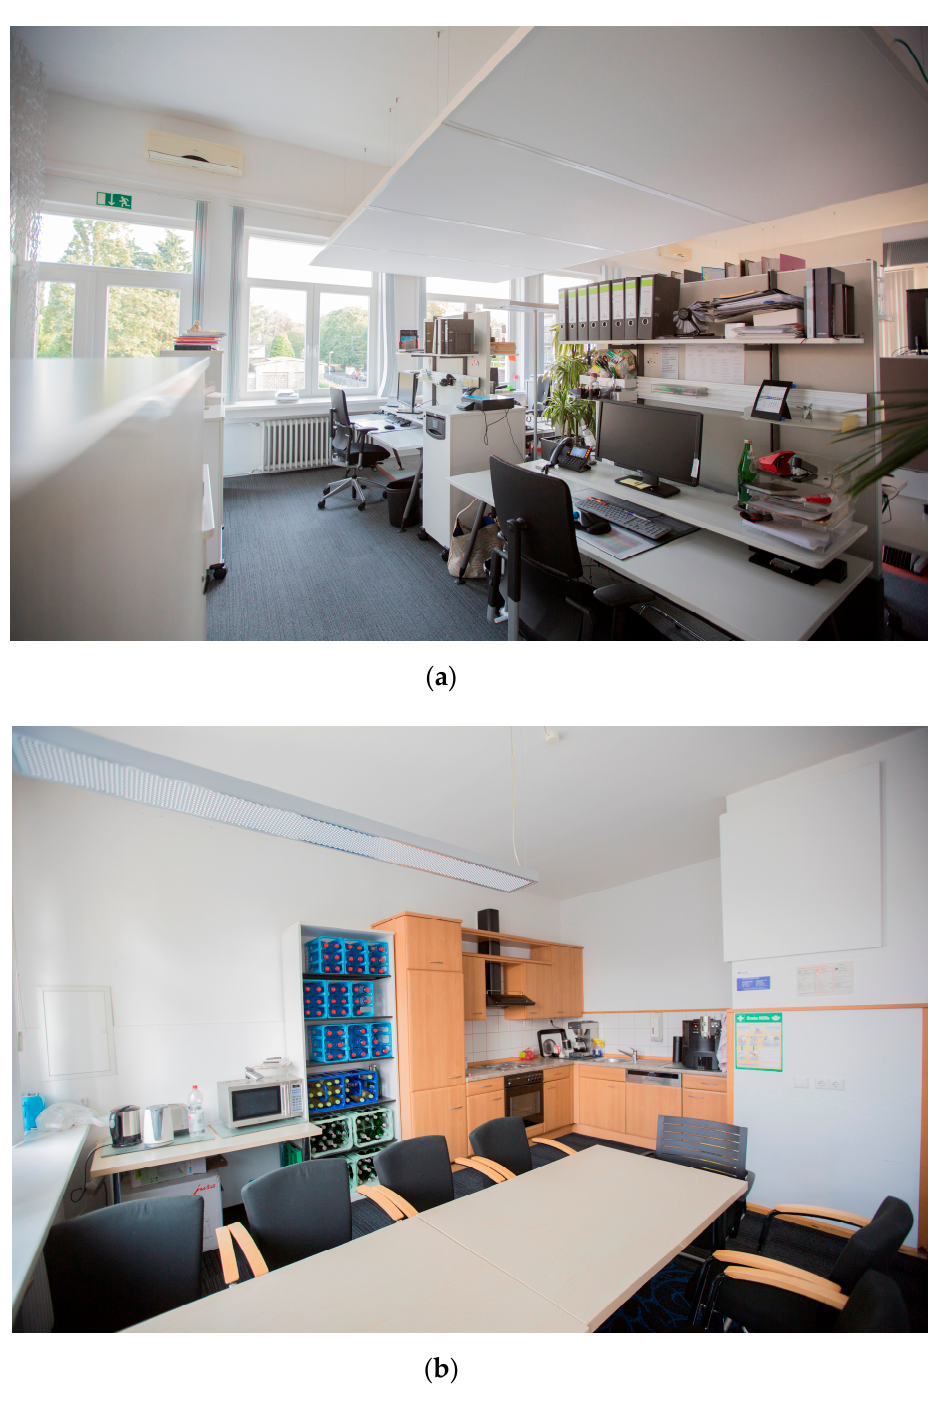
Figure 1. (a) Old office—employees’ work desks (image: ©Lichthalle Krefeld); (b) Old office— Figure 2. ( a ) Old o ffi ce—employees’ work desks (image: © Lichthalle Krefeld); ( b ) Old o ffi ce—kitchen (image: © Lichthalle kitchen (image: ©Lichthalle Krefeld).